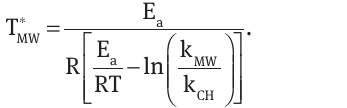
on α under the CH (●) and ai, α j j